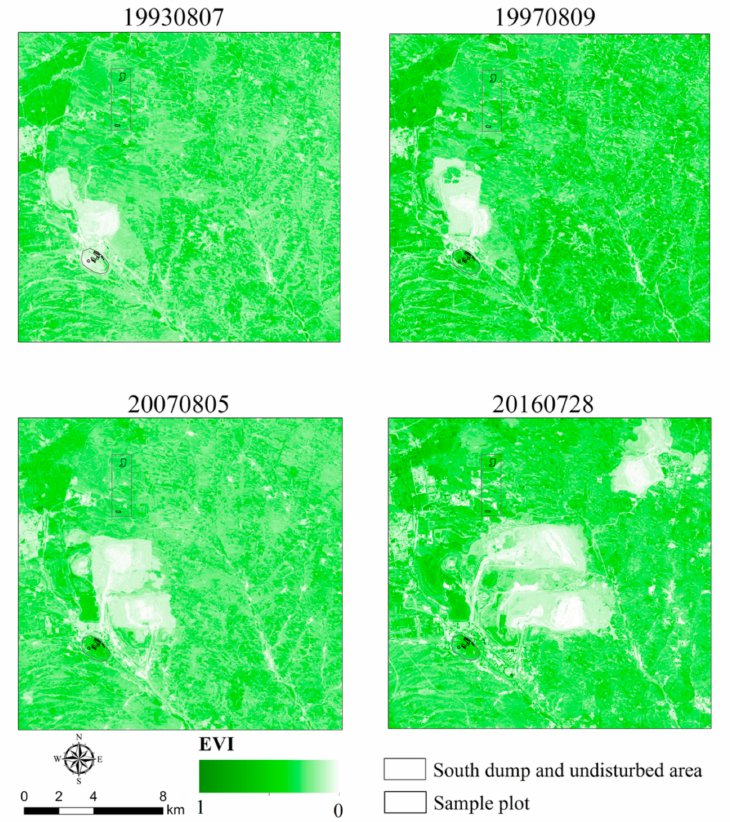
Figure A1. EVI data